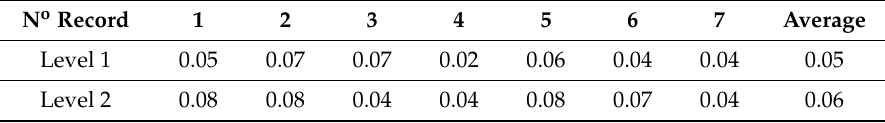
Figure 18. Force-displacement curve of the slip-plate dampers under Imperial-Valley-6 earthquake scaled to Level 2.